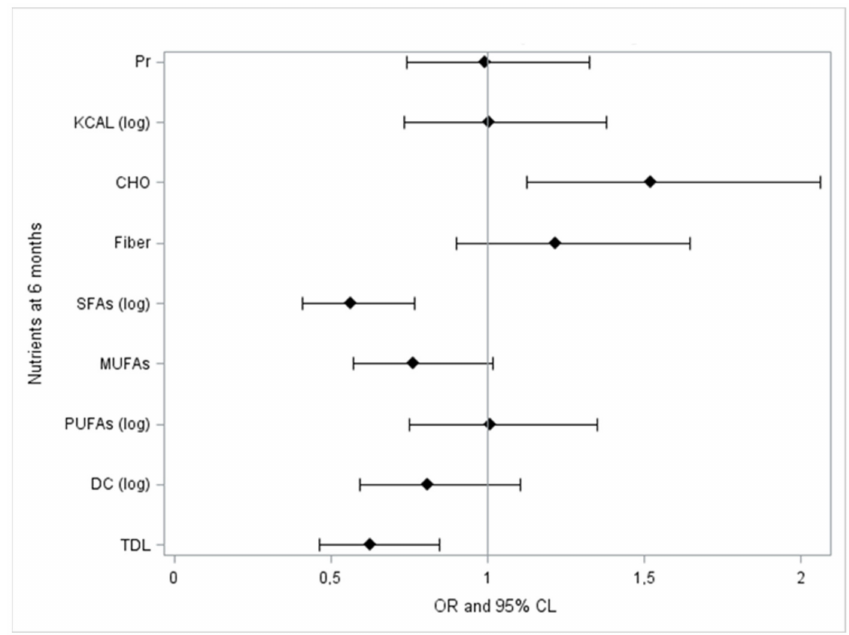
Figure 3. Standardized odds ratio of macronutrients at T1 adjusted for age and sex. CL, 95% confidence limits.